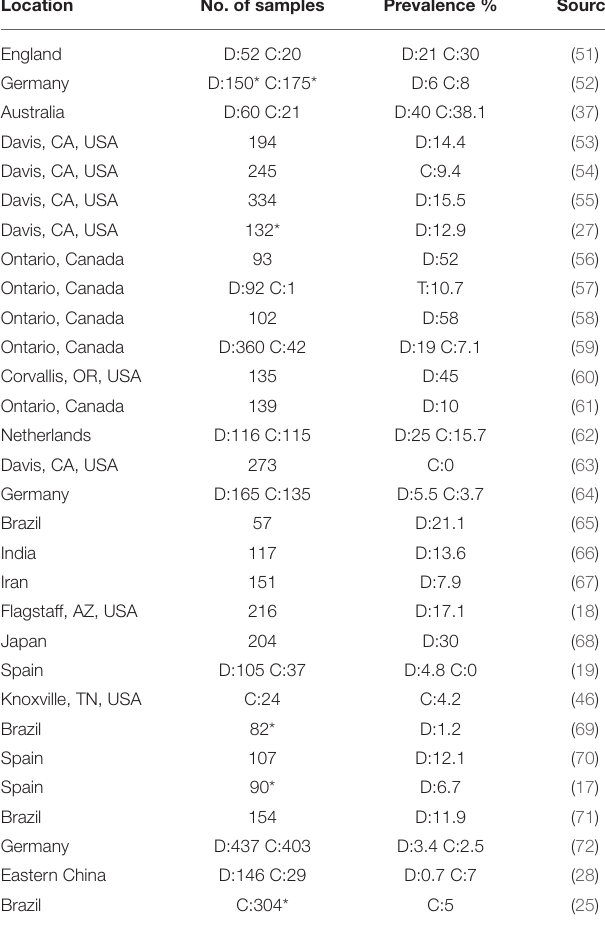
TABLE 1 | Prevalence of Clostridioides difficile in dogs and cats. Location No. of